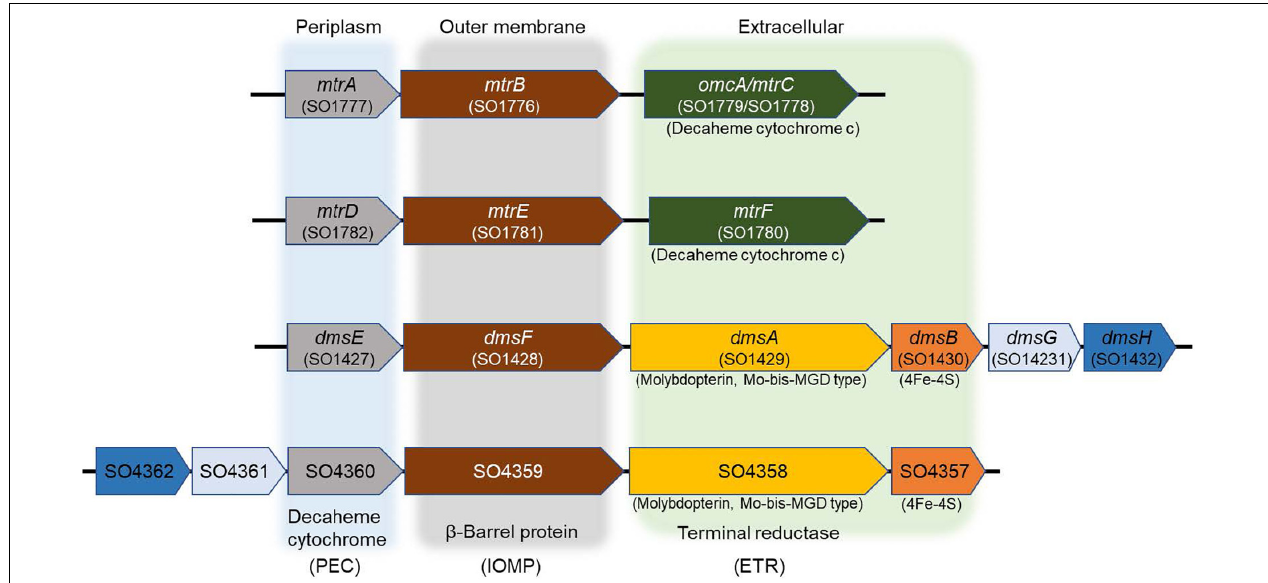
FIGURE 1 | Mtr paralogs of extracellular electron conduits (EEC) system responsible for anaerobic respiration in S. oneidensis. PEC, periplasmic electron carrier; IOMP, integral outer membrane β -barrel protein; ETR, extracellular terminal